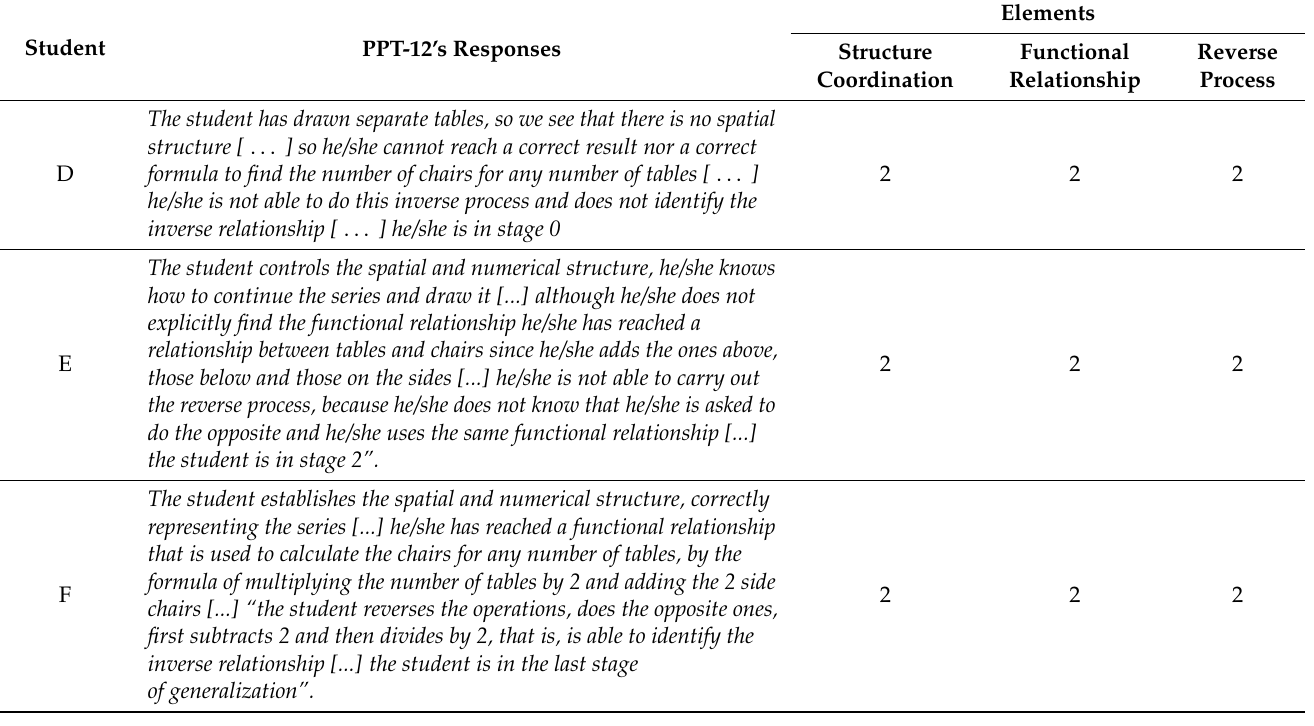
Table 12. PPT-12’s responses from Profile